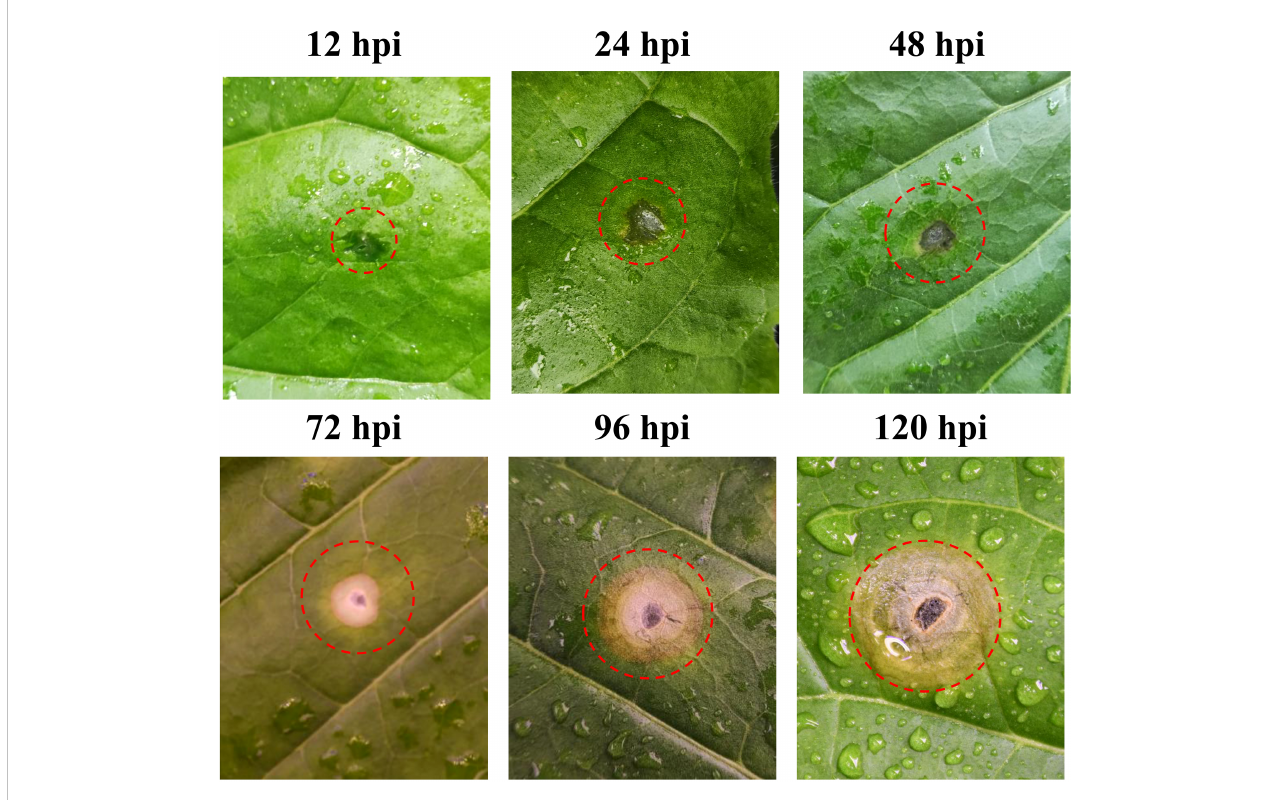
FIGURE 1 Disease symptoms of tobacco plants after Rhizoctonia solani